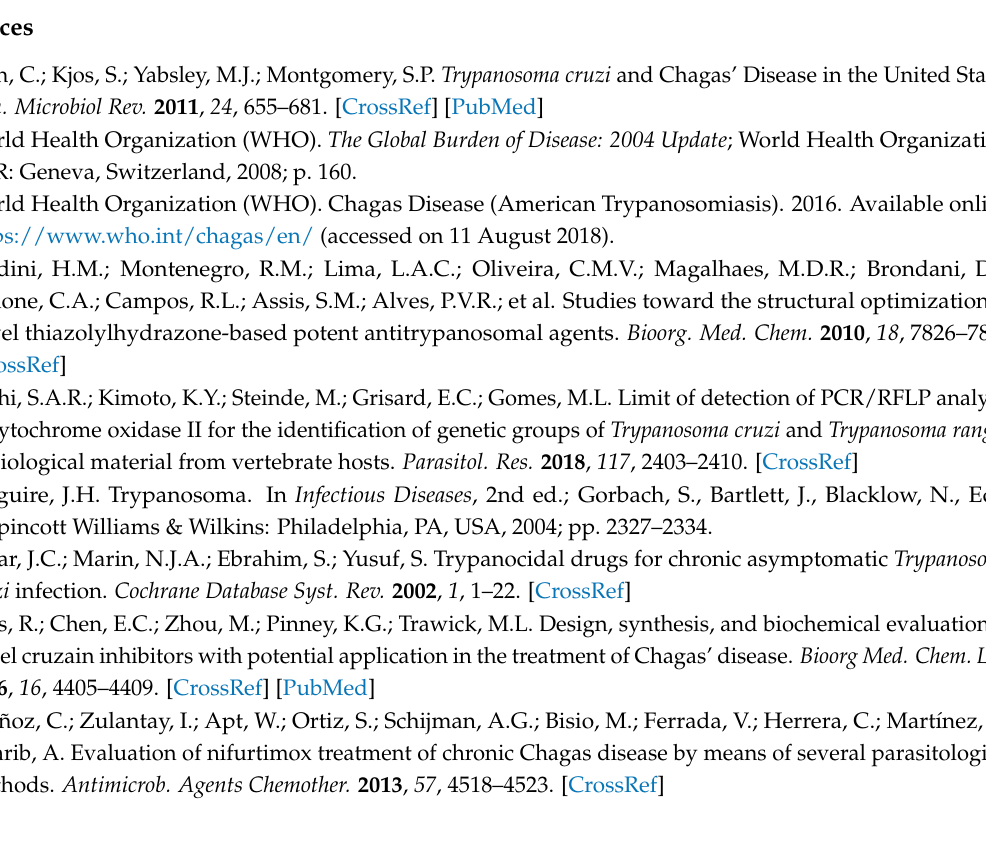
Table S1: Compounds obtained from virtual screening, binding energies and chemical